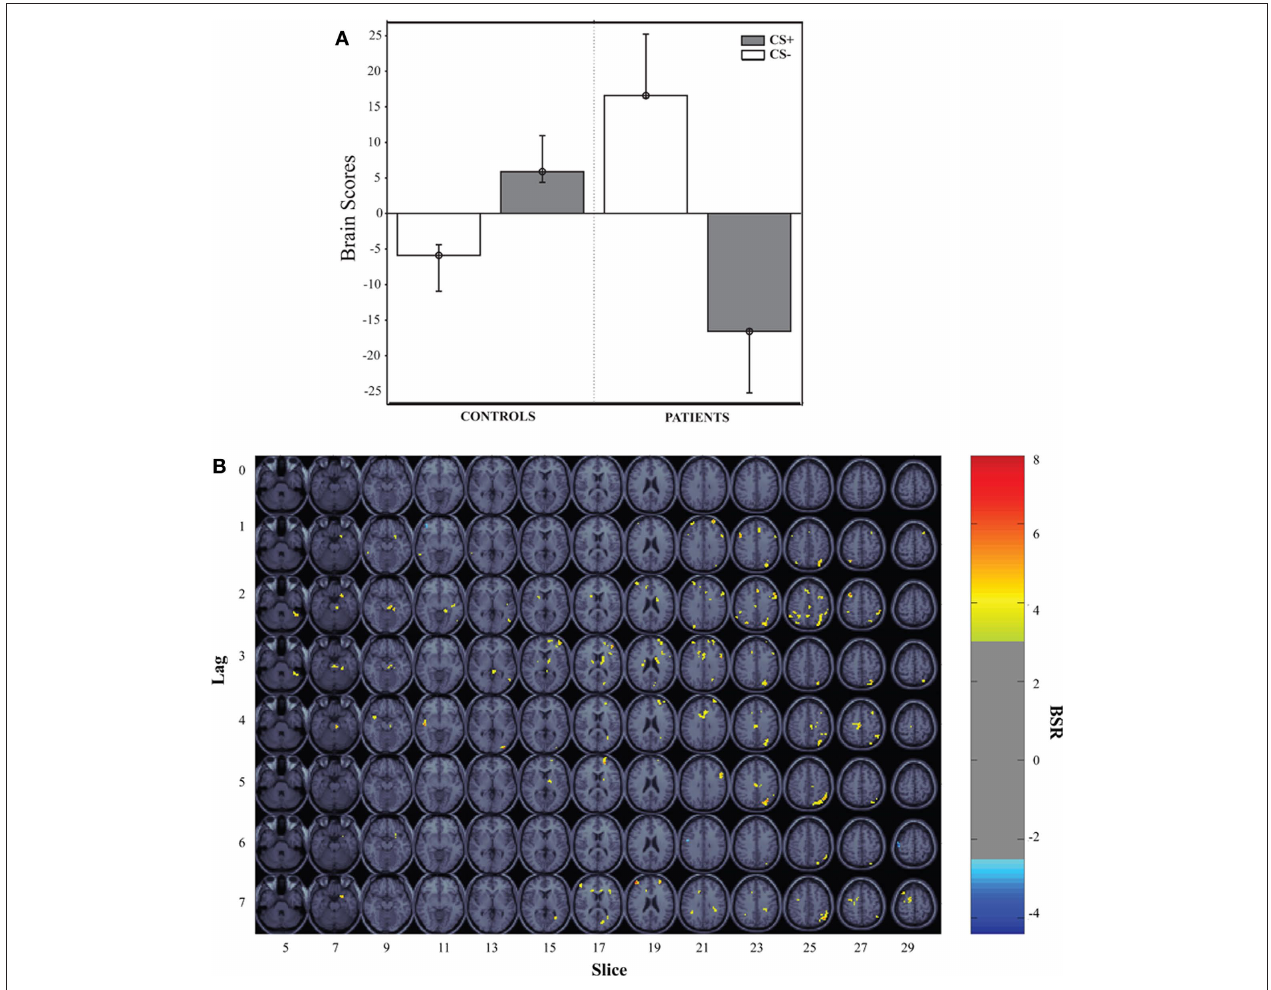
entire length of the experimental tasks pertaining to LV1. The bars represent 95% confidence intervals around the mean. Bootstrap estimation is used to derive confidence intervals around the subjects’ brain scores for each condition, in each group. (B) The regions that showed increased activity in response to the CS + are superimposed over standard MRI